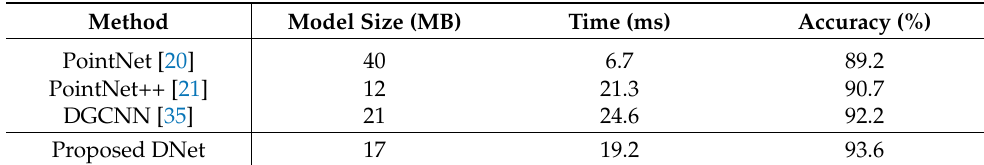
Table 2. Comparison of different methods on model complexity, forward time, and classification accuracy.